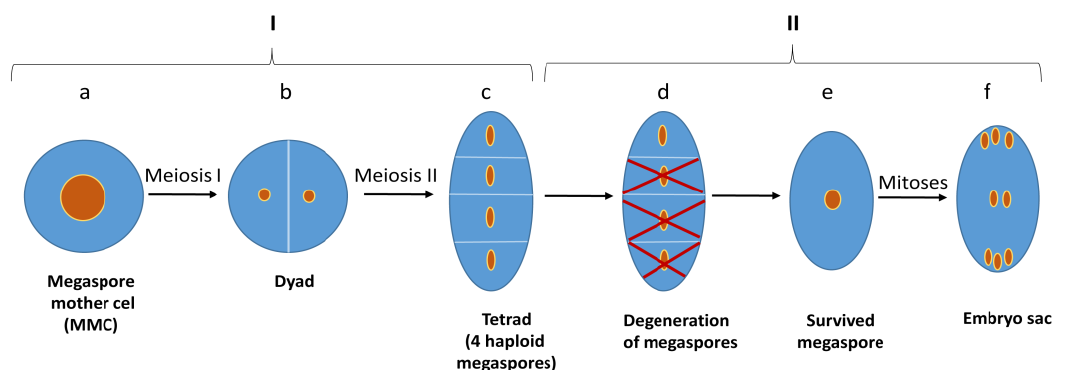
Figure 4. Schematic diagram illustrating monosporic path of the embryo sac development. Embryo sac development occur in ovaries located within a flower. Phase I is macrosporogenesis, phase II is macrogametogenesis. During microsporogenesis, the MMC ( a ) undergoes meiosis ( b ) and four haploid spores are produced ( c ). During macrogametogenesis, three spores degenerate ( d ), and the survived megaspore ( e ) undergoes mitosis, leading to the development of an eight-nucleus embryo sac ( f ).